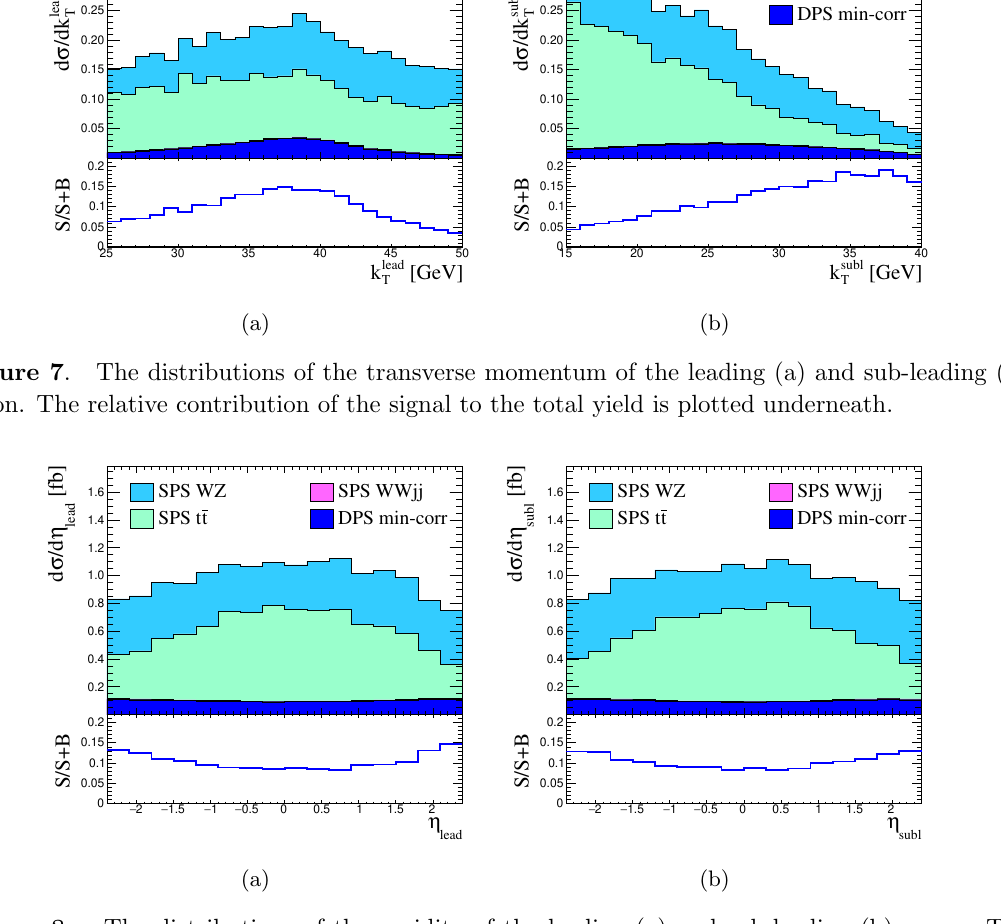
Figure 8 . The distributions of the rapidity of the leading (a) and sub-leading (b) muon. The signal contribution to the total yield is drawn at bottom to optically capture its